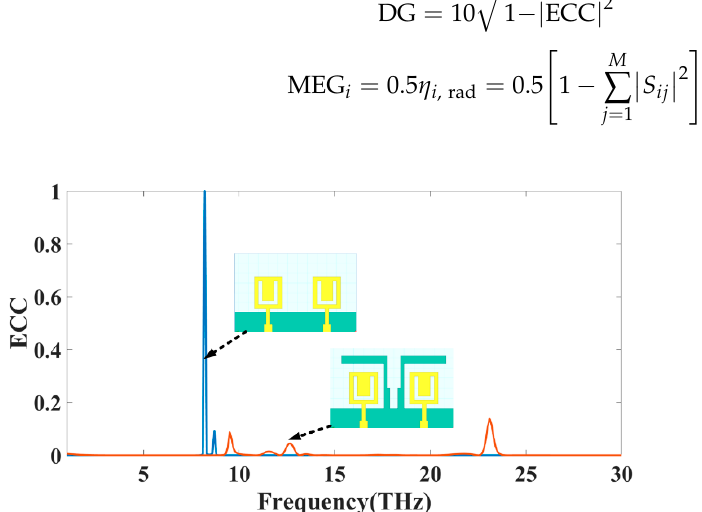
Figure 3. The simulated value of the ECC for MIMO structure Design 3 and Design 4.